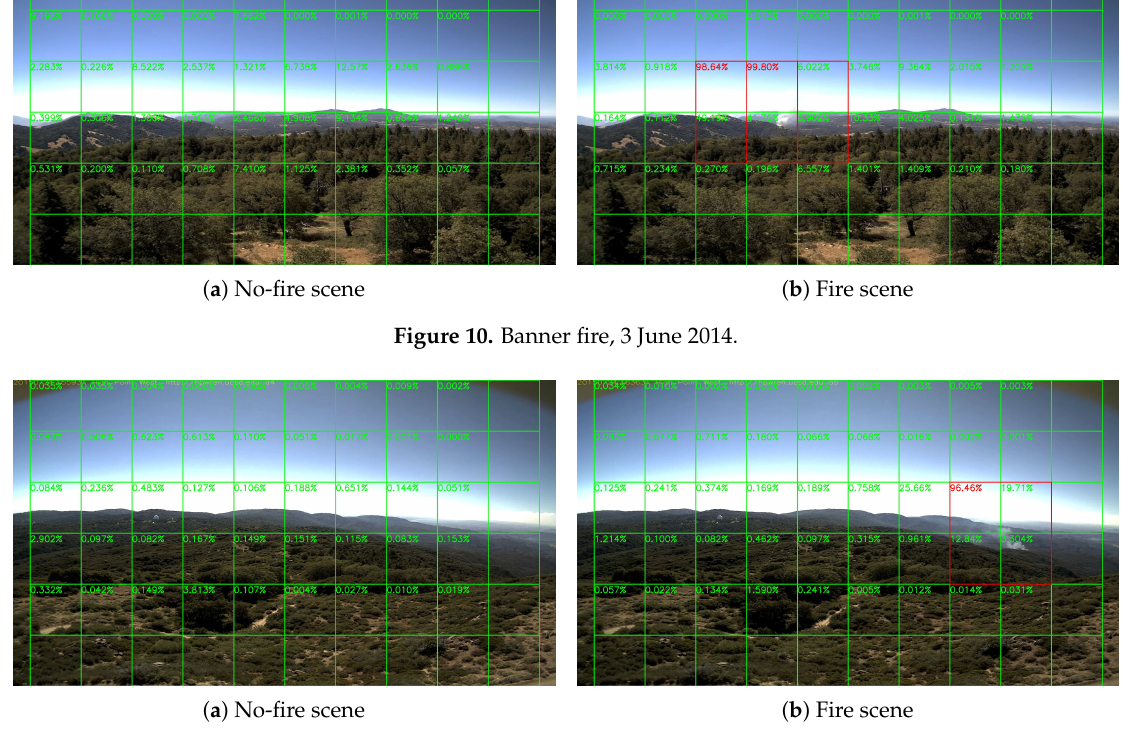
Figure 11. Palomar Mountain fire, 24 July 2015.